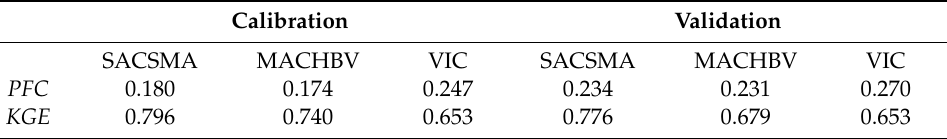
Table 1. Performance statistics of the three hydrological models from calibration and validation. The definition of the abbreviations is presented in Section